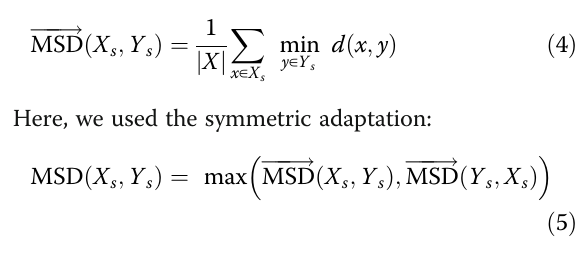
Table 3 Evaluation results after training segmentation architectures on different training sets Test datasets (DSC) for lung slices only DSC ± SD HD95 (mm)